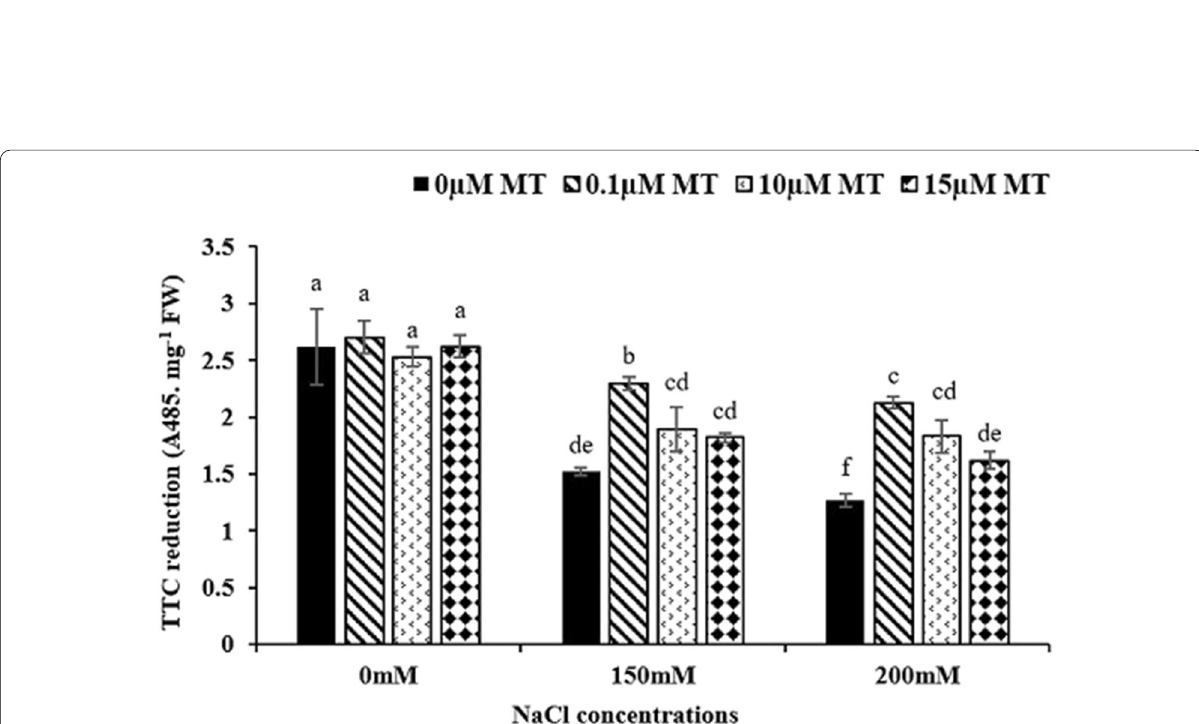
Fig. 2 Effects of melatonin and salt pretreatment on root viability in alfalfa roots. Data represents the mean of replicates letters indicate significant differences based on Duncan’s multiple range test (P <